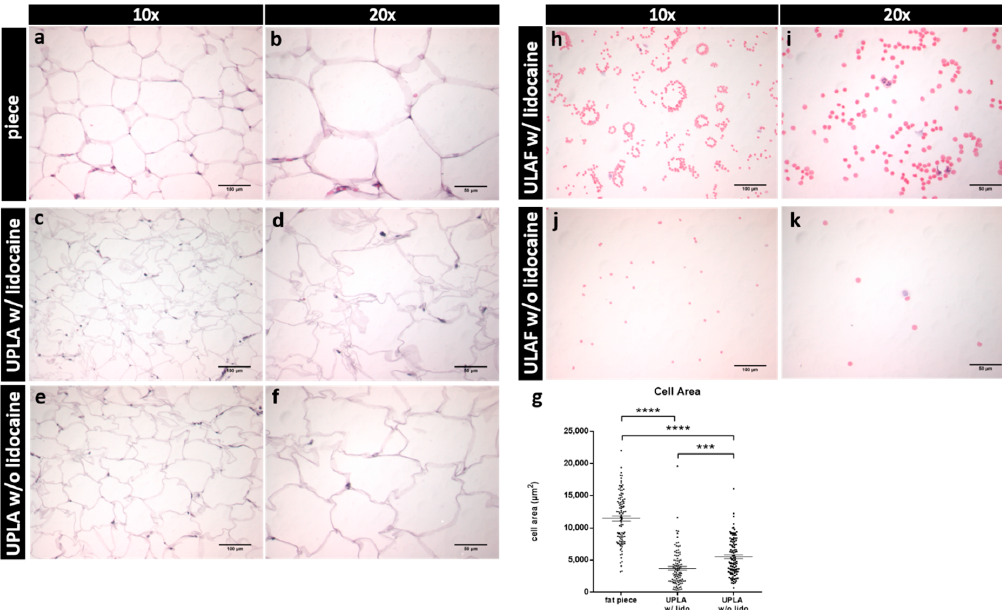
Figure 1. The fat piece and the unprocessed fatty portion (UPLA) after paraffin embedding and Hematoxylin-Eosin (HE) staining, as well as the unprocessed fluid portion (ULAF) after HE staining are shown. Slides were observed in a light microscope. In panels ( a ) and ( b ), a fat piece harvested by surgical extraction w/lidocaine is seen in 10× and 20× magnification. In panels ( c ) and ( d ), the UPLA harvested by liposuction w/lidocaine and in panels ( e ) and ( f ) w/o lidocaine is shown in 10× and 20× magnification. In panel ( g ), the cell area (in µm 2 ) of the cross-sections from the fat tissue piece and the UPLA w/and w/o lidocaine of 100 random mature adipocytes (20 cells in 5 fields of views = 100 cells, 10× magnification) was compared. The mean and standard error of the mean are shown. *** p < 0.001; **** p < 0.0001. In ( h ) and ( i ), the ULAF of the lipoaspirate w/lidocaine, and in ( j ) and ( k ), w/o lidocaine is shown in 10× and 20× magnification.